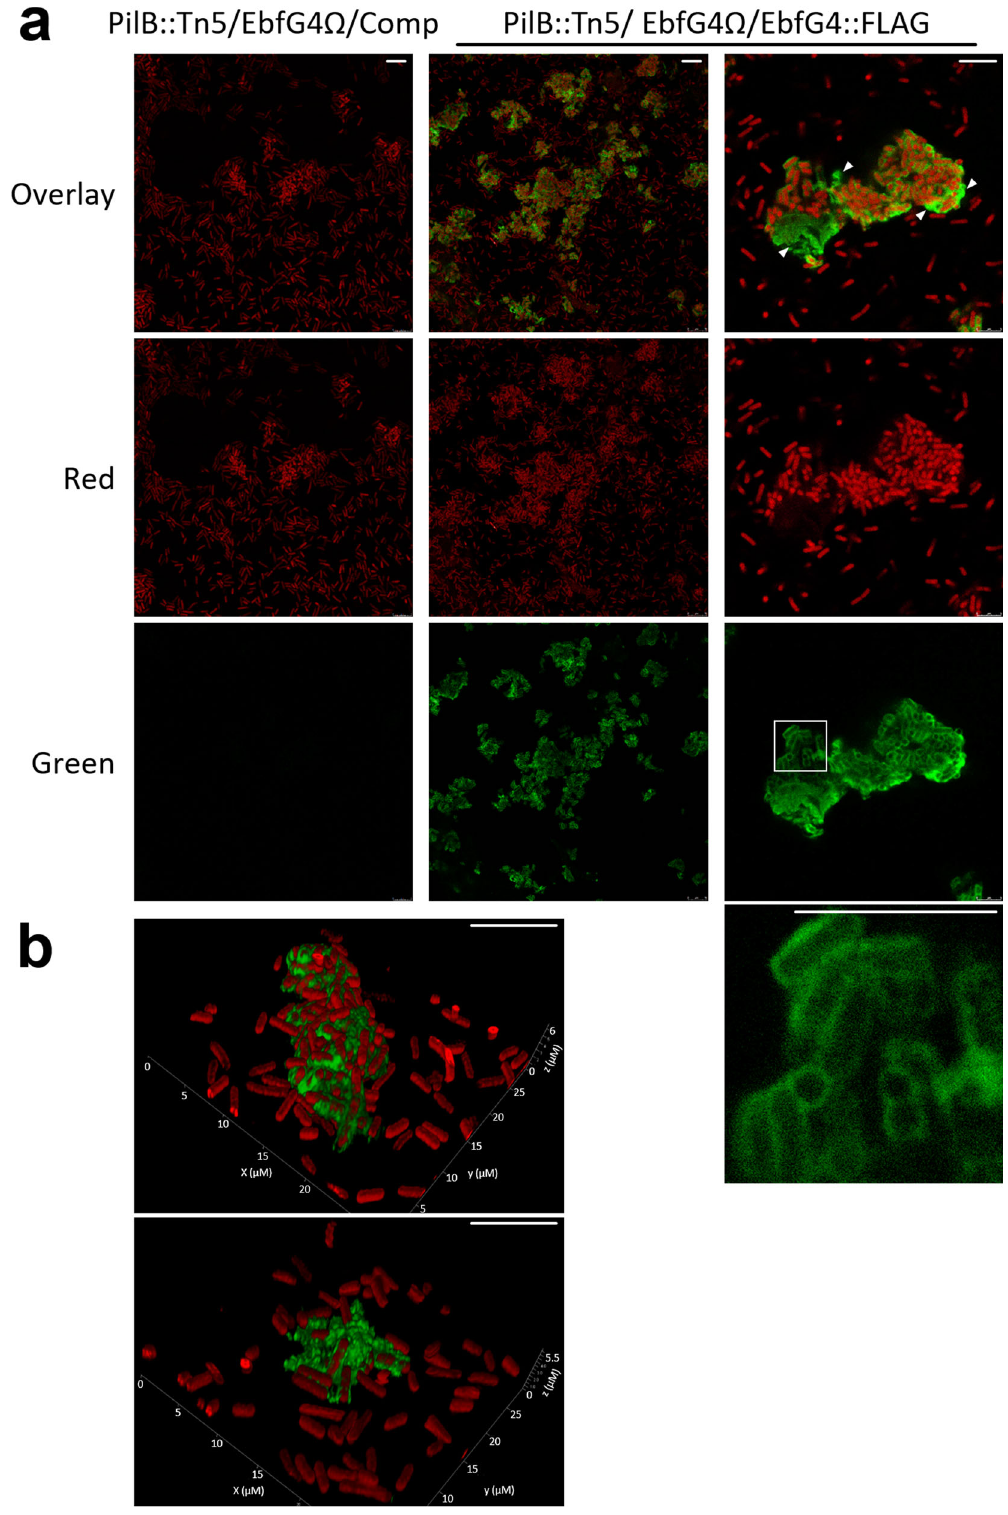
Fig. 4 Visualization of EbfG4::FLAG in non-permeabilized cells by immunocytochemistry and confocal fl uorescence microscopy. a Strains analyzed: PilB::Tn5/EbfG4 Ω /Comp and PilB::Tn5/EbfG4 Ω /EbfG4::FLAG. Red represents auto fl uorescence whereas green indicates the presence of EbfG4::FLAG. White square indicates the enlarged area shown in the panel below. Arrowheads point at patches of green fl uorescence in areas void of cells. b 3D-imaging of strain PilB::Tn5/EbfG4 Ω /EbfG4::FLAG. The scale bars correspond to 10